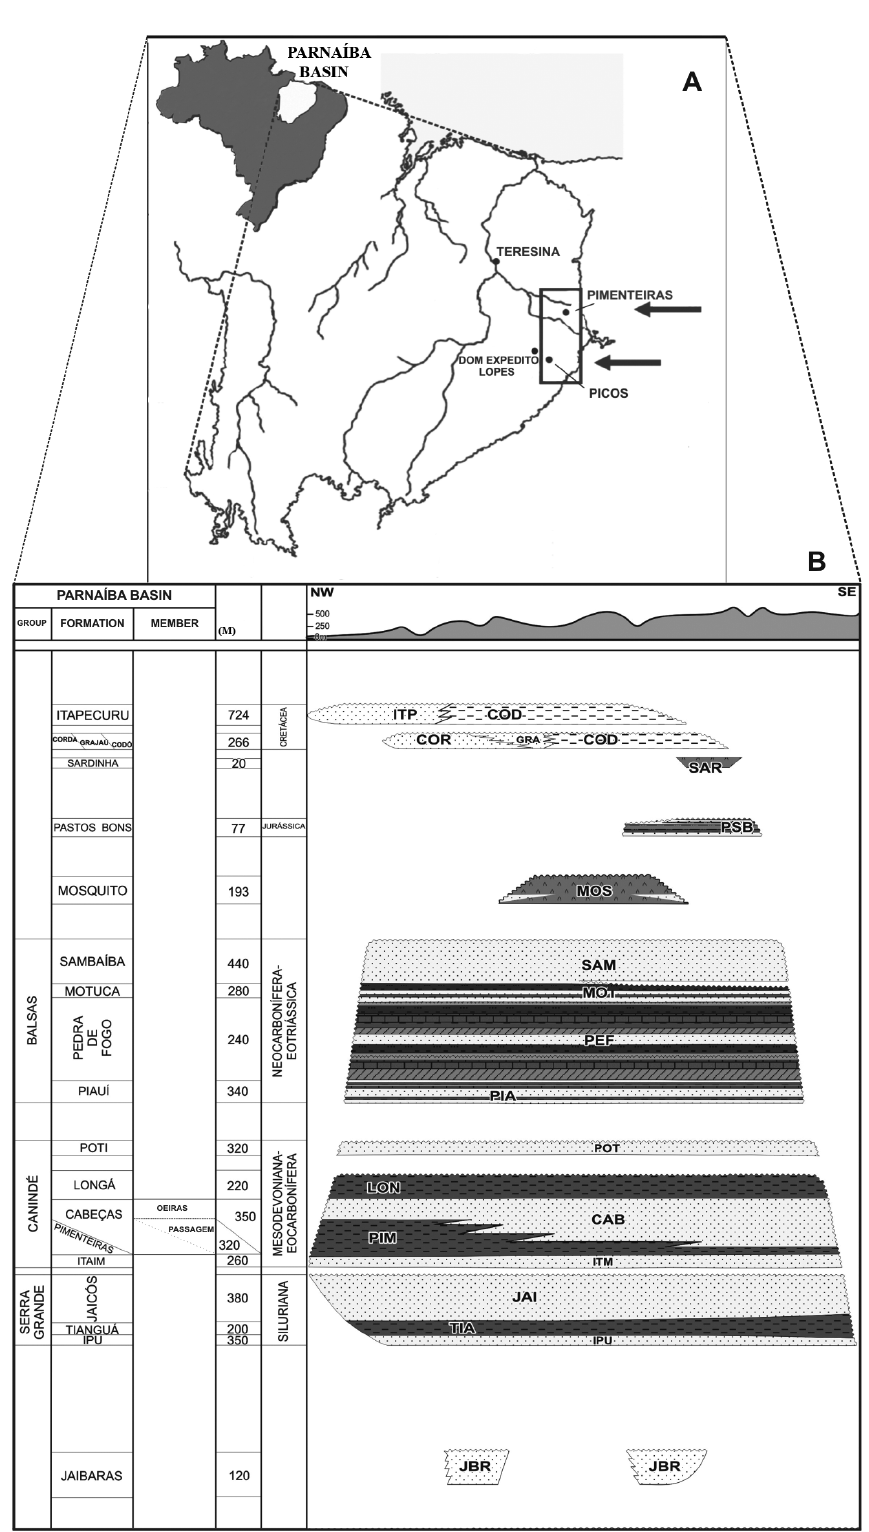
Fig. 1 – (A) Simplified map of Piauí State, with arrows pointing to the towns of Picos and Pimenteiras, on the eastern margin of the Parnaíba Basin, northeastern Brazil. (B) Stratigraphic chart of the Parnaíba Basin (modified from Vaz et al.